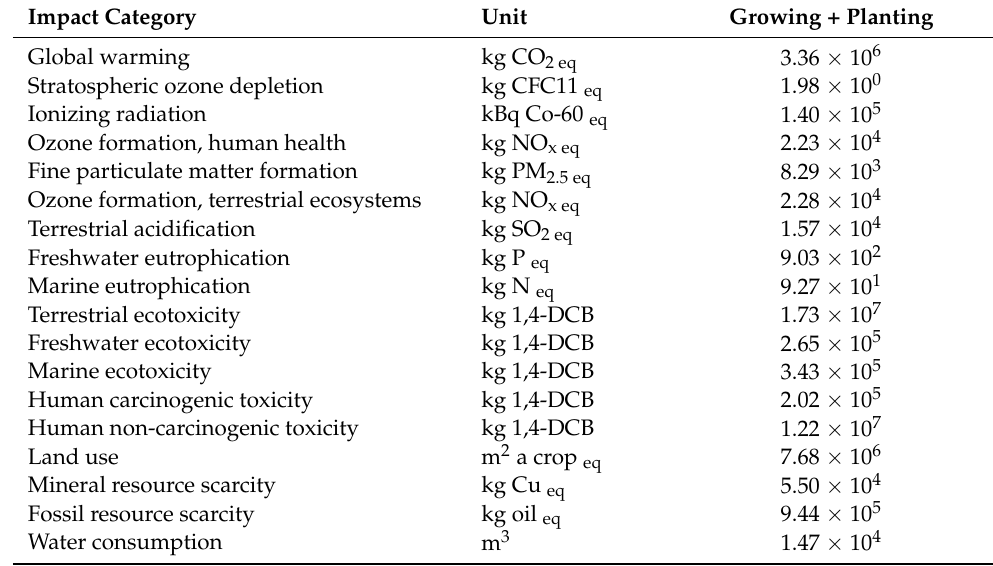
Table 7. Characterized ReCiPe midpoint impacts for growing and planting 2.34 million tree